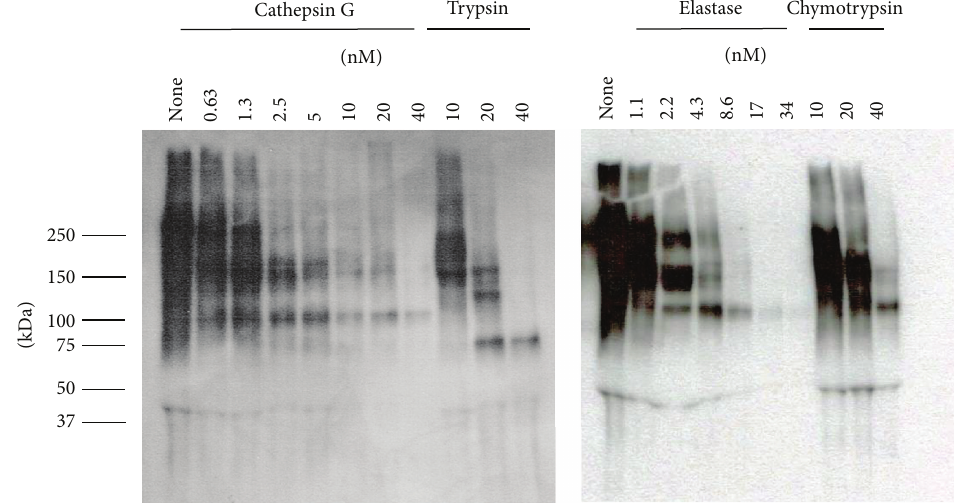
Figure 4: Residual amounts of FN on the bottoms of FN-coated wells that had been treated overnight with each protease. FN bound to the bottoms was collected after a washing and analyzed by western blotting as described in Section